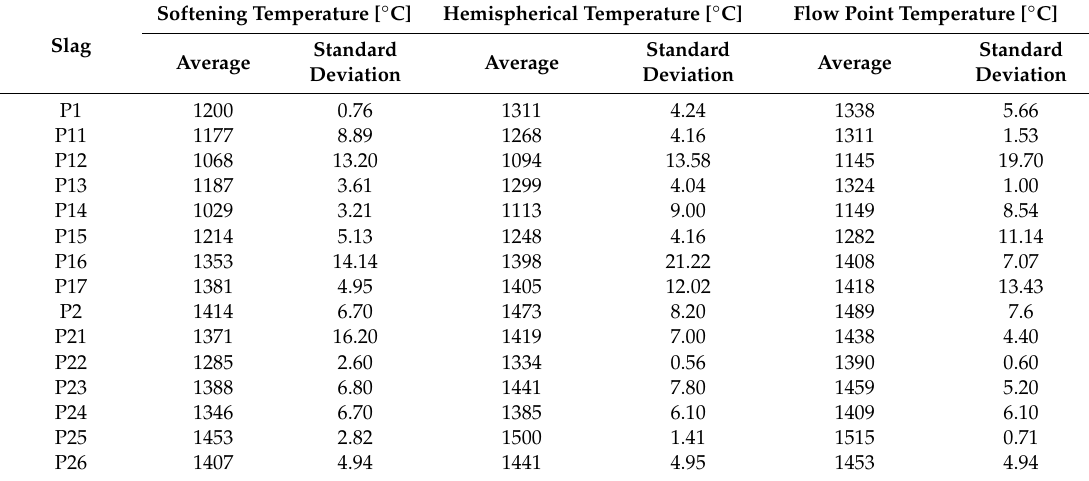
Table 3. Measured softening, semi-spherical, and flow temperatures of the BOF slags. Softening Temperature [ ◦ C] Hemispherical Temperature [ ◦ C] Flow Point Temperature [ ◦ C] Slag Standard Standard Standard Average Average Average Deviation Deviation